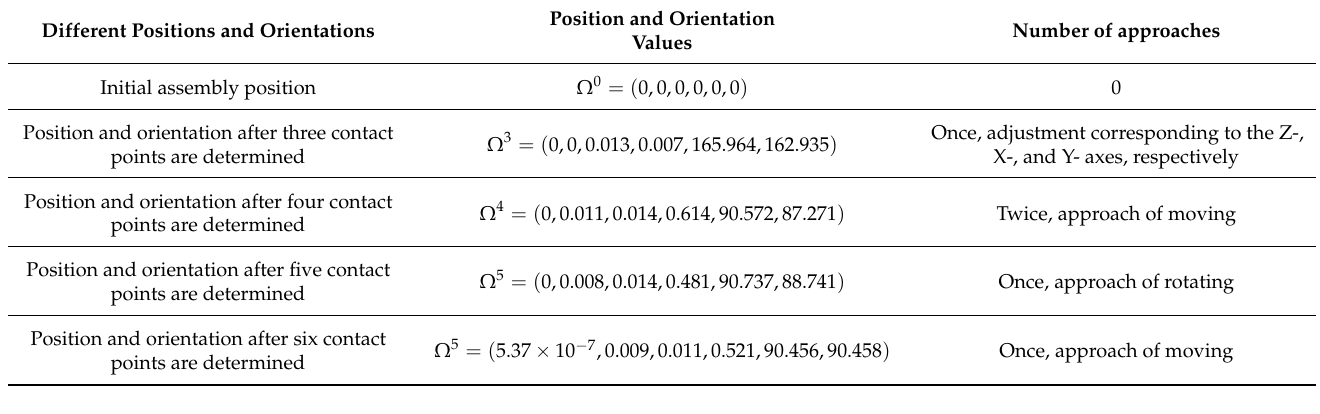
Table 3. Positions and orientations approaching progressively over the whole process.